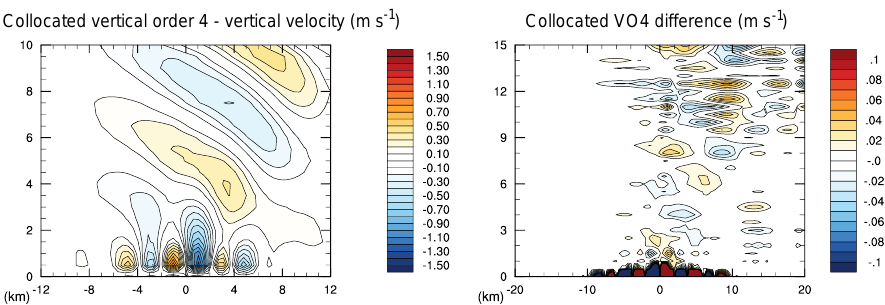
Figure 7. Schär flow at steady state (10h). Collocated method (all variables on column levels) results compared to staggered (Lorenz) solution at the same spatial order and resolution. (cid:49)x = 200m and (cid:49)z = 200m. Contour intervals: vertical velocity 0 . 1ms − 1 and vertical velocity difference versus reference 0 . 0125ms − 1